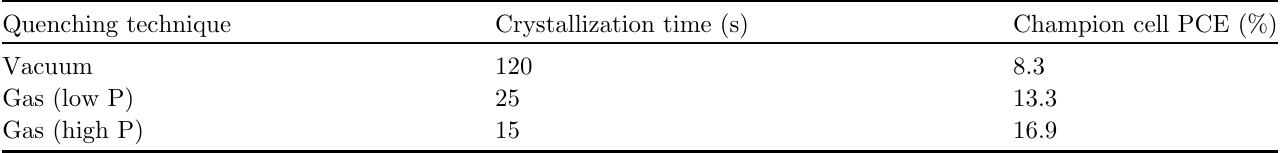
Table 5. Summary of the champion cell ef fi ciencies obtained with different quenching techniques. Quenching